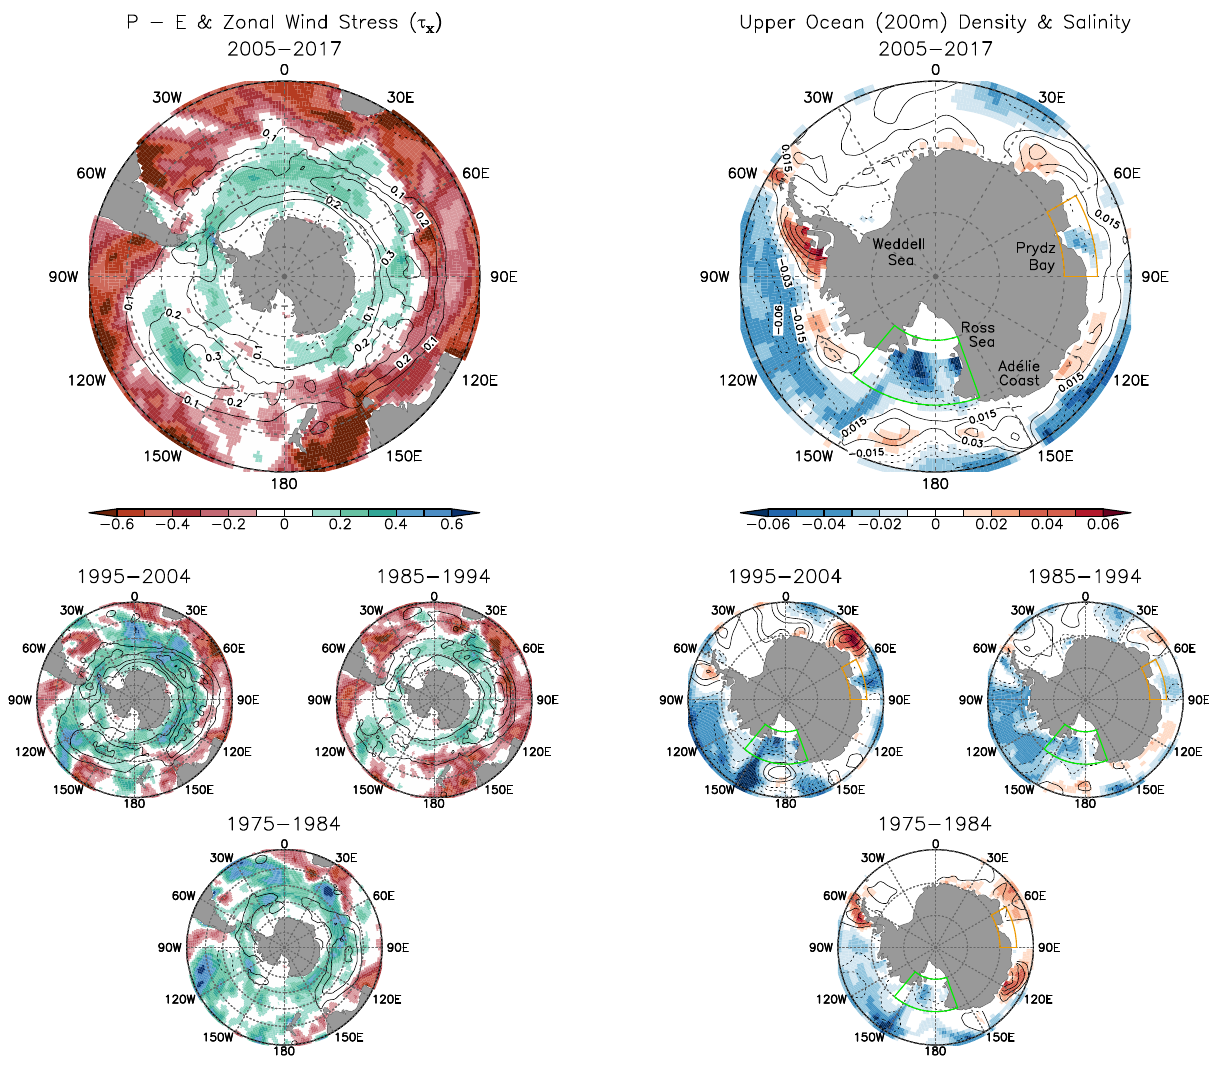
Fig. 4 Changes in surface forcing and upper ocean properties. Changes in (left panels) surface zonal wind stress (contours) and precipitation minus evaporation (P − E, shades) between 90°S and 30°S, and (right panels) upper 200 m density (shades) and salinity (contours) between 90°S and 60°S during 2005 – 2017, 1995 – 2004, 1985 – 1994 and 1975 – 1984 from the base period of 1955 – 1974. The units are dyne cm − 2 , mm s − 1 , σ 2 , and PSU for wind stress, P − E, density, and salinity, respectively. Green boxes in the right panels indicate the Ross Sea region. Orange boxes in the right panels indicate the Prydz Bay